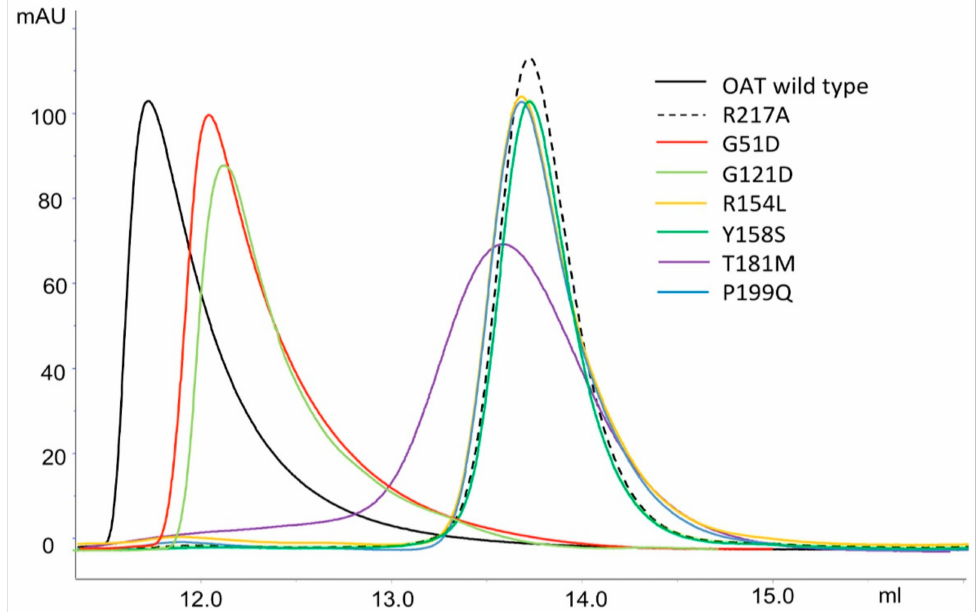
Figure 5. Sec analysis of the quaternary structure. hOAT wild-type, the artificial OAT dimeric variant R217A and the pathogenic variants G51D, G121D, R154L, Y158S, T181M and P199Q were loaded at 10 µ M enzyme concentration on a Superdex 200 10/300 Increase column equilibrated in HEPES 50 mM pH 8.0, NaCl 150 mM, 20 µ M PLP. Chromatographic profiles were analyzed by Unicorn v7.3 software (GE Healthcare, Chicago, IL,